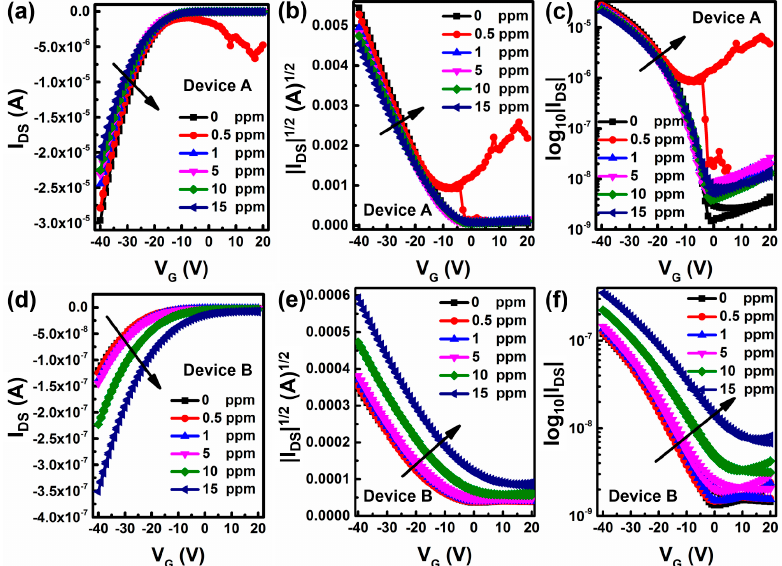
Figure 3. Transfer curves of devices A and B under a specific concentration of NO 2 , ( a , d ) without calculation, ( b , e ) after taking log, ( c , f ) after extracting.